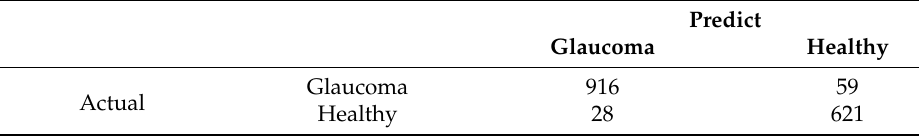
Table 7. Confusion matrix of the proposed prediction model.